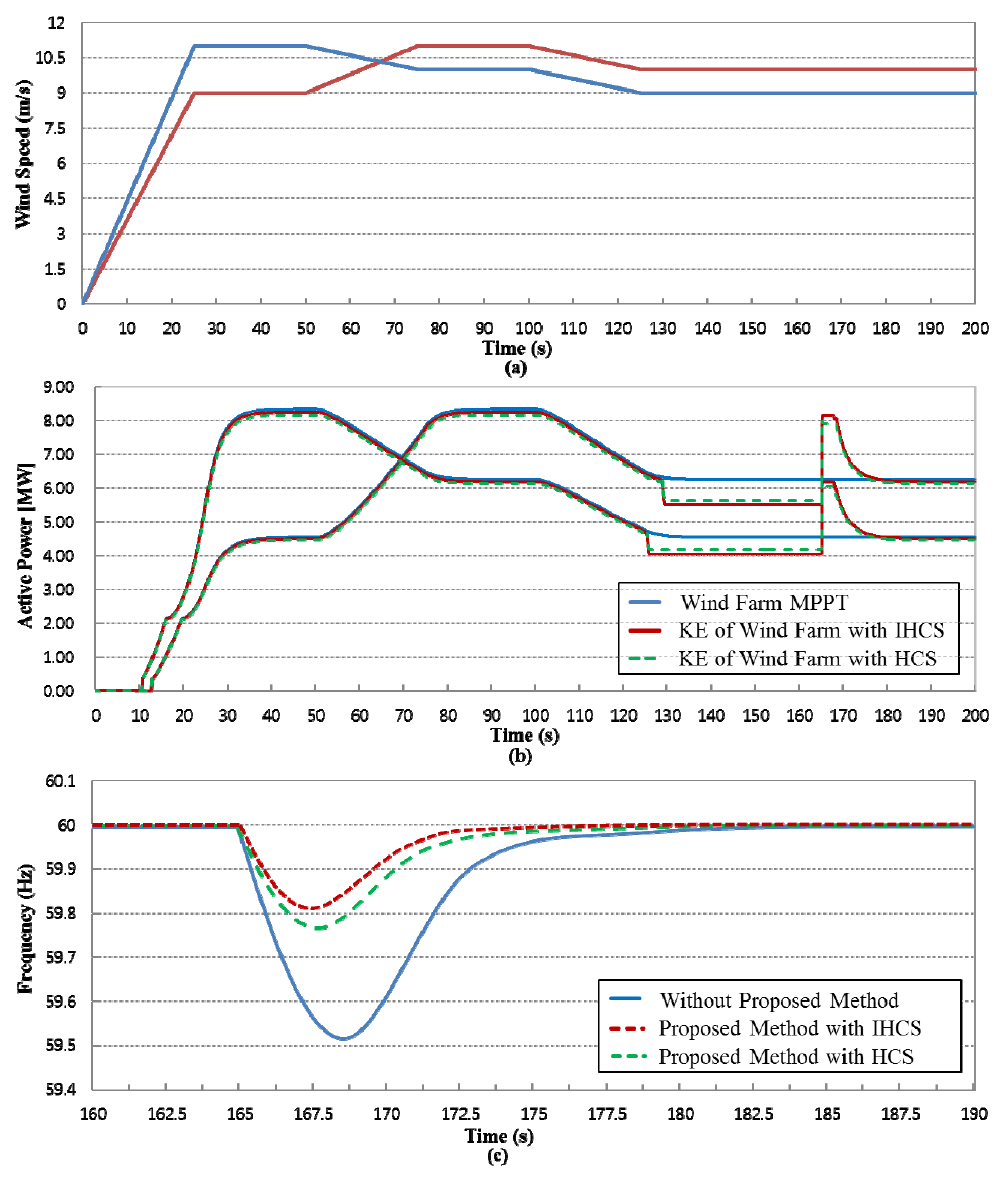
Figure 14. ( a ) Wind speed profile for WF1 and WF2; ( b ) variation of active power for WF1 and WF2; ( c ) frequency